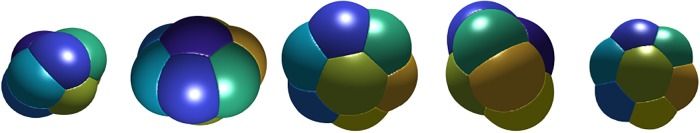
The left panel shows another stationary equal-area 8-foam with larger total surface area than the 8-foam in Fig 8.The middle three panels show xy-, xz-, and yz-views of the 8-foam. The right panel shows another view showing the hexagonal shaped bubble on the top. A corresponding video can be found here: youtu.be/4_uAeq19qJY.